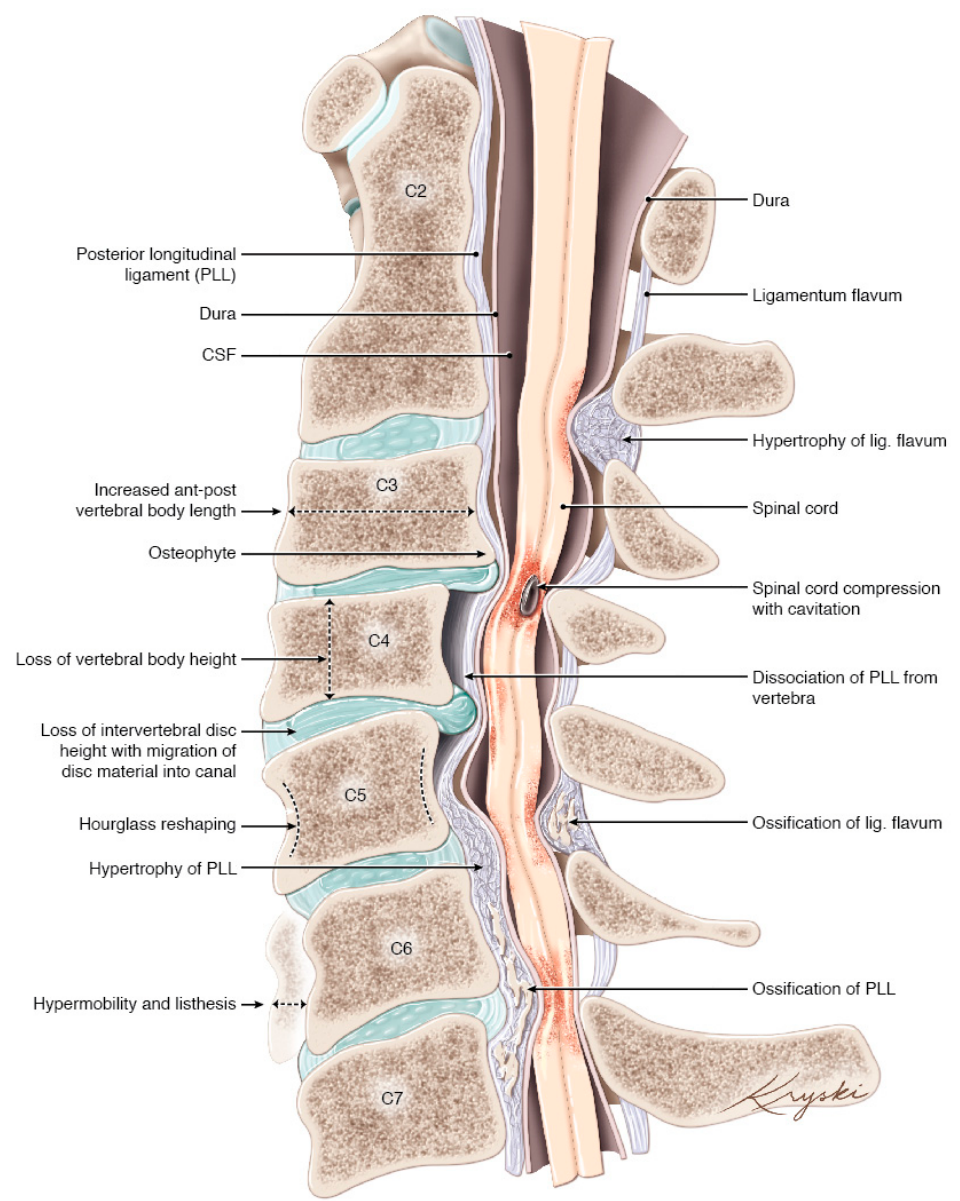
Figure 1. Artistic depiction of the various degenerative changes that can be seen in patients with DCM (Concept Aria Nouri, edits Michael G. Fehlings, artwork design Diana Kryski). CSF = Cerebrospinal Fluid, PLL = Posterior Longitudinal Ligament. Originally published in Nouri et al. Degenerative Cervical Myelopathy: Epidemiology, Genetics and Pathogenesis. Spine (Phila Pa 1976). 2015;40(12): E675-93.